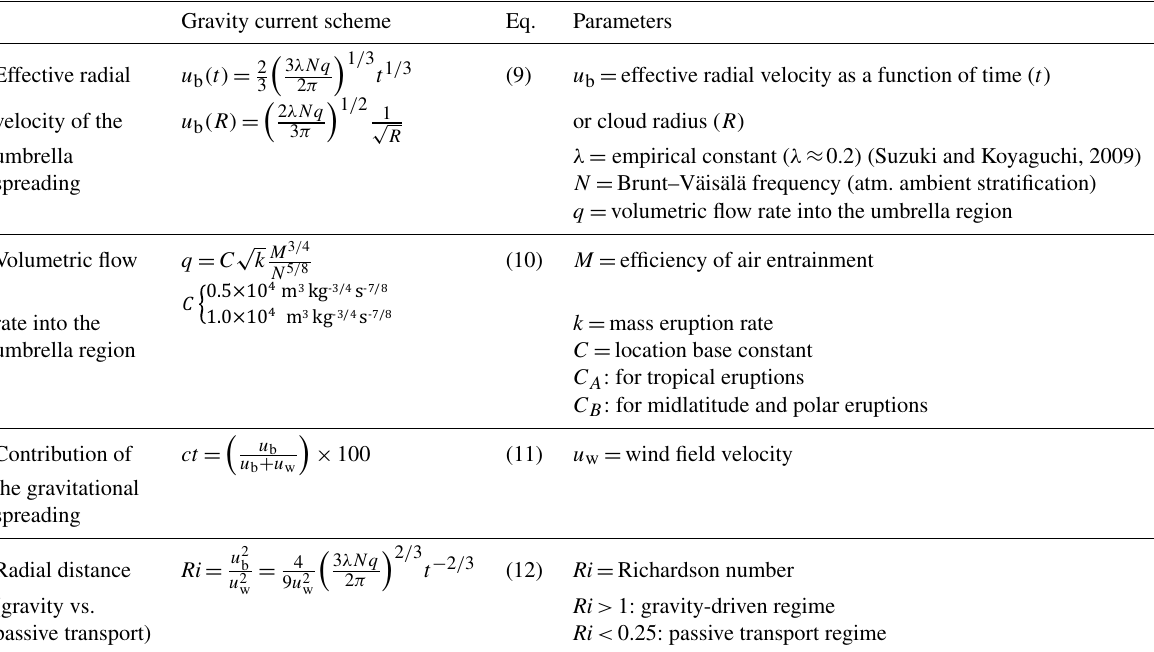
Table 5. Governing equations for NMMB-MONARCH-ASH gravity current model.